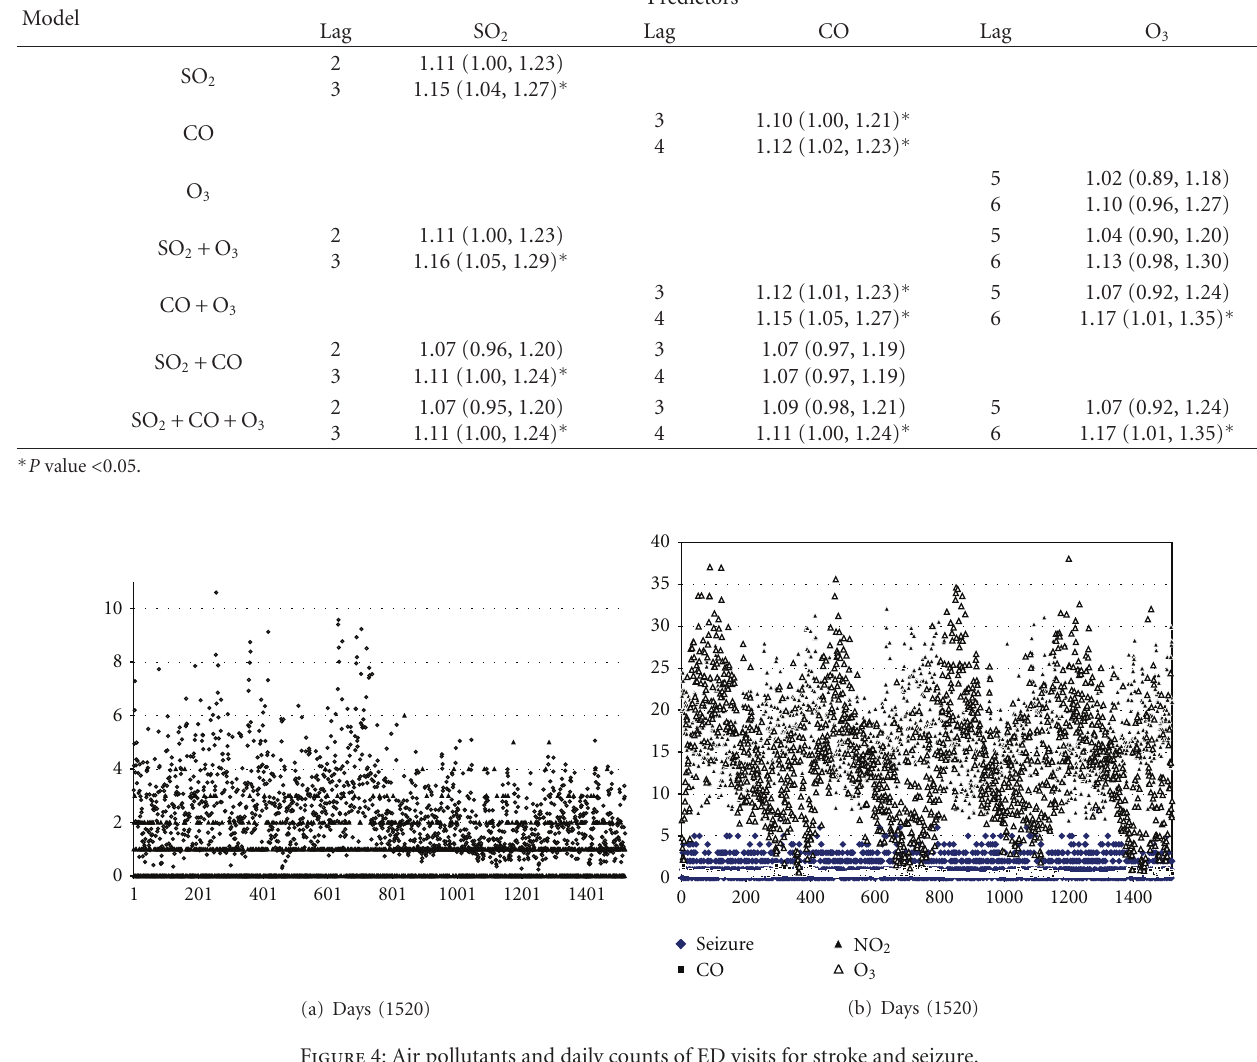
Figure 4: Air pollutants and daily counts of ED visits for stroke and